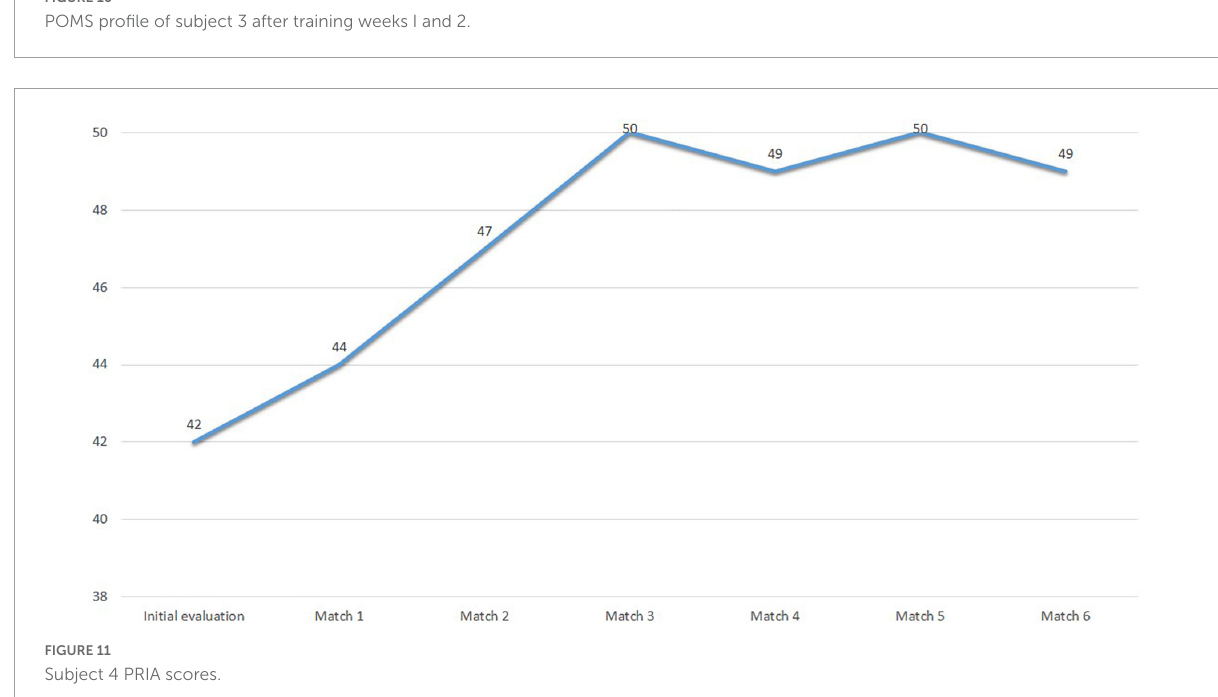
FIGURE11 Subject 4 PRIA